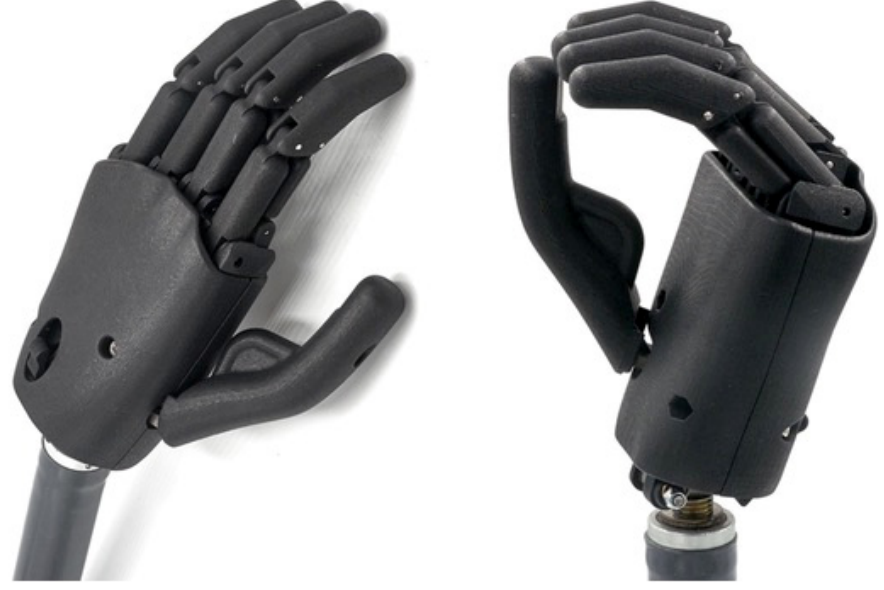
Figure 1. The Self Grasping Hand without cosmetic glove applied.